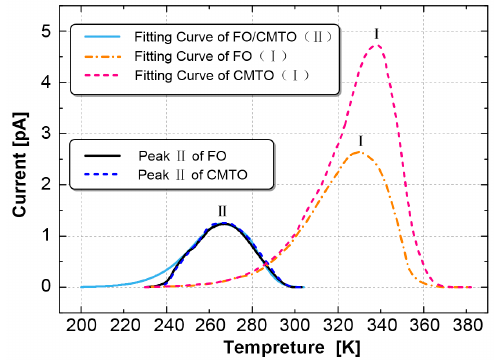
Figure 12. Measured curve of peak II of FO and CMIO and fitting curve of peaks I and II.